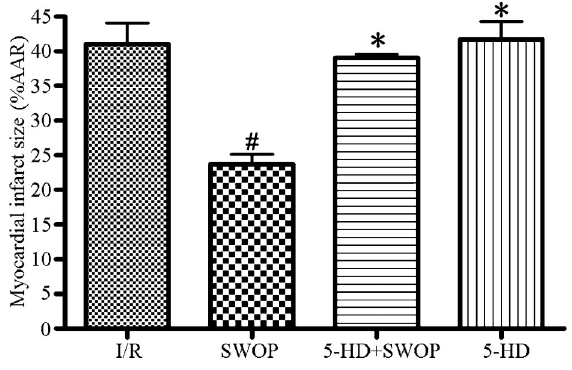
Figure 1. Myocardial infarct size after 2 h of reperfusion. AAR: area at risk, I/R: ischemia/reperfusion; SWOP: second window of protection; 5-HD: 5-hydroxydecanoate. # P , 0.05 vs I/R group; *P , 0.05 vs SWOP group (one-way ANOVA).